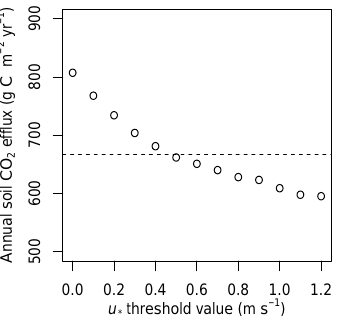
Figure 9. Diurnal pattern of soil CO 2 efflux measured by the au- tomated chambers during the fan experiment, based on bi-hourly means ( ± standard deviation). Panel (a) shows the diurnal pattern for half of the chambers with and without fans, where the first 10 days were with fans (filled circles) and the last 10 days were without fans (open circles). Panel (b) shows the diurnal pattern with and without fans for the other half of the chambers, where the first 10 days were without fans (open circles) and the last 10 days were with fans (filled